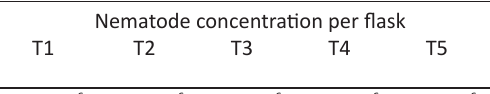
Table 4. Multiplication of Steinernema saimkayai in Dog feed medium Nematode concentration per flask